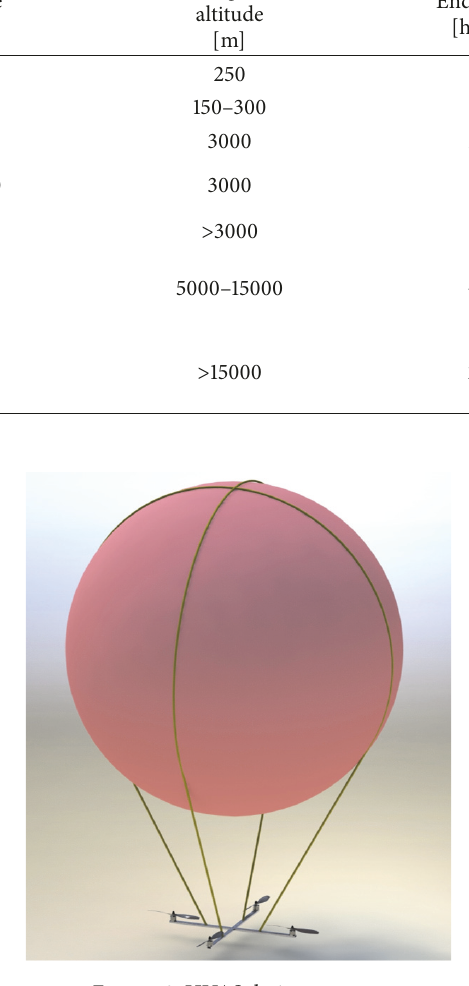
Figure 2: HUAS design